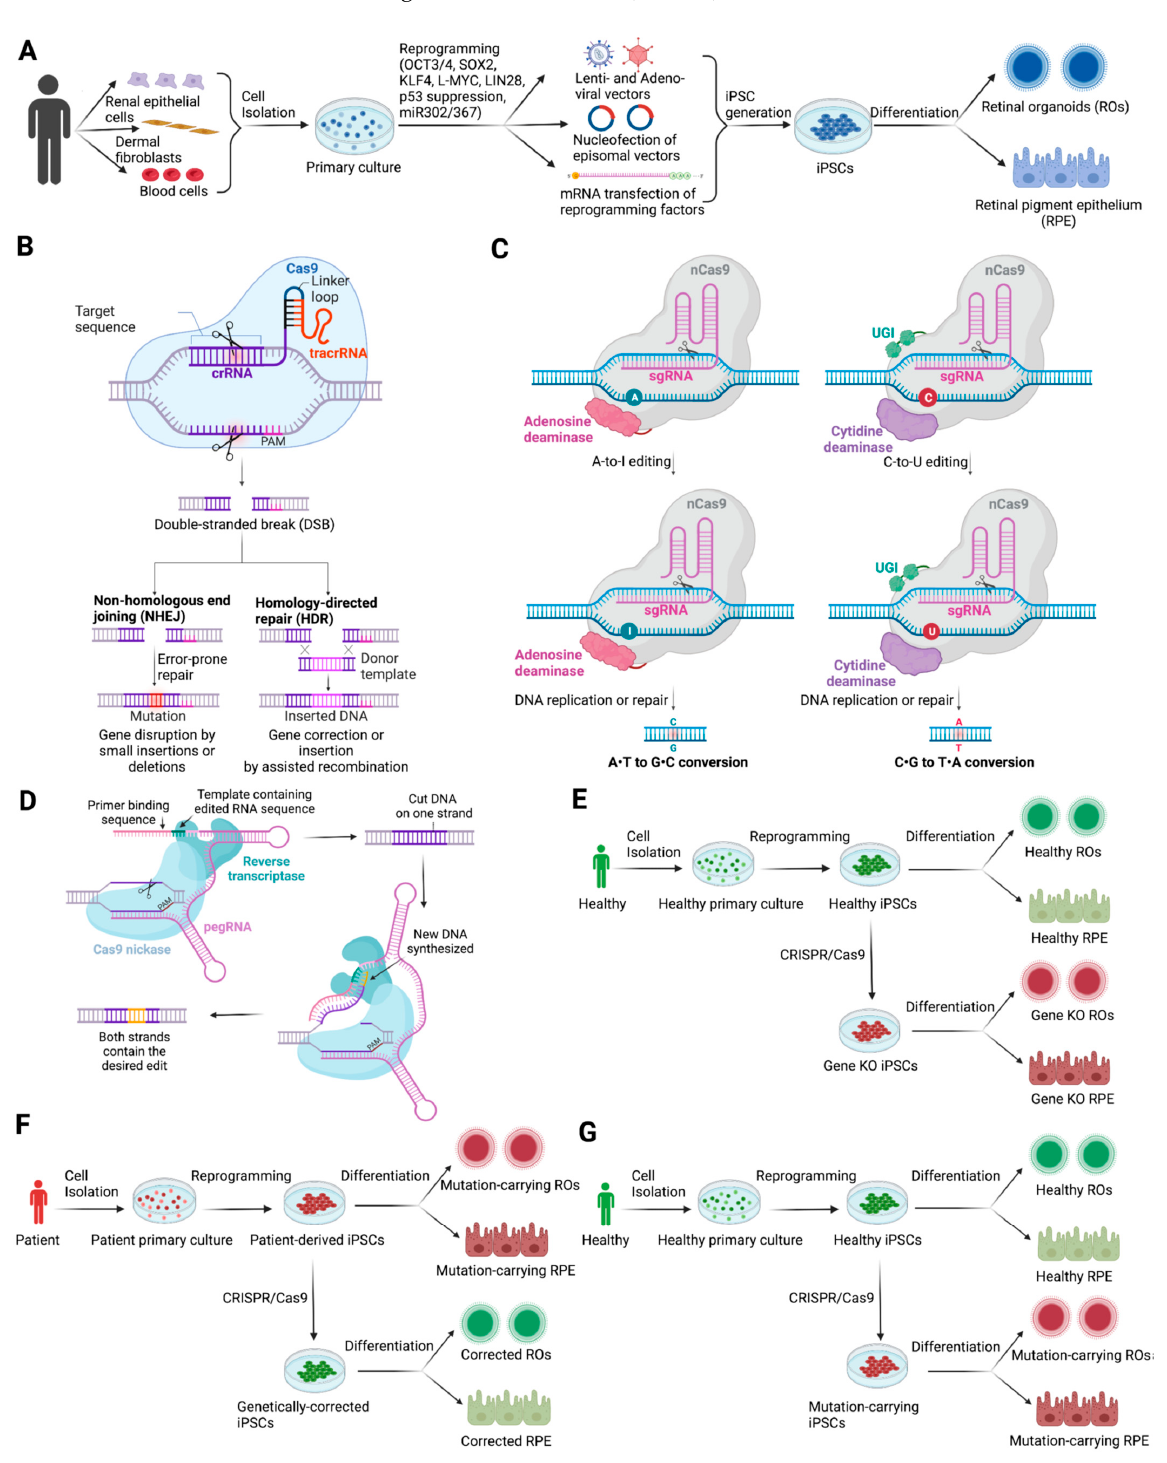
Figure 1. Generation of in vitro models to study inherited retinal dystrophies (IRDs). ( A ) Schematic diagram of sources of patient somatic cells, reprogramming methods into induced pluripotent stem cells (iPSCs), delivery methods of reprogramming factors and differentiation approaches for generating retinal organoids (ROs) and retinal pigment epithelium (RPE). ( B ) Introduction of DNA double-stranded breaks (DSB) by Cas9 endonuclease directed to a predetermined genomic locus